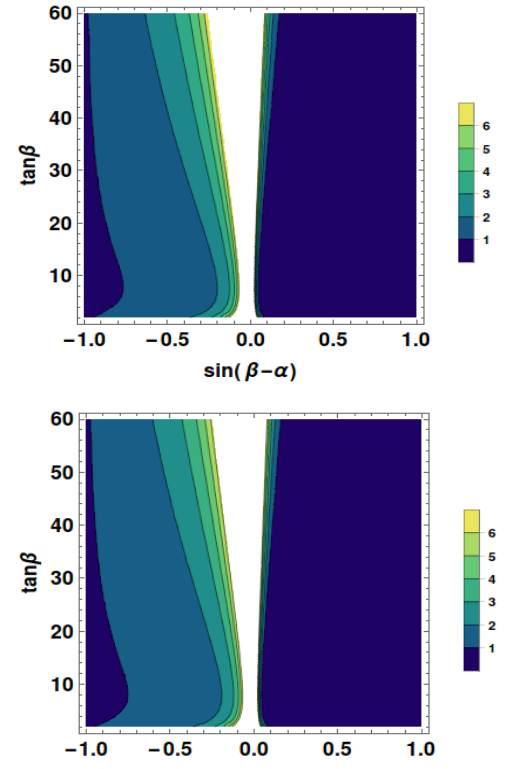
=600 GeV. H (cid:6)